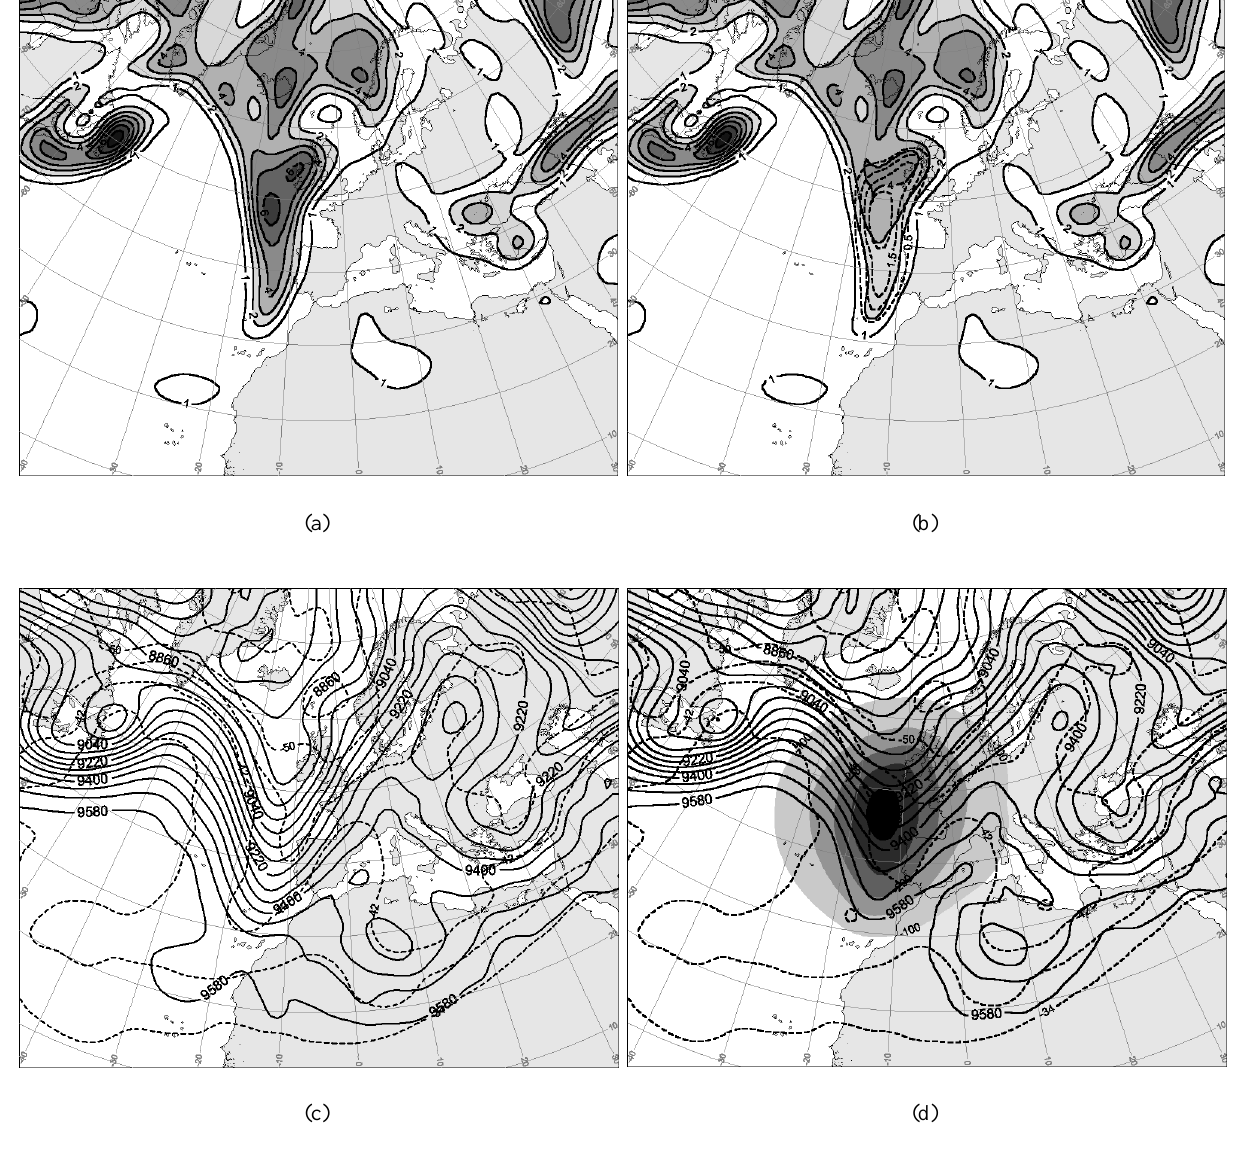
Fig. 15. Upper panels: Potential Vorticity (PVU) at 300hPa on 12:00UTC, 20 October 2000 associated with the initial conditions of (a) control run and (b) weakened trough experiment (see text for details). Dashed line in b) depicts the eliminated PV anomaly at 300hPa. Lower panels: Geopotential height (gpm, solid line) and temperature ( ◦ C, dashed line) at 300hPa on 12:00UTC, 20 October 2000 for (c) control run and (d) the weakened trough experiment. Shading in d) depicts the areas with difference of geopotential height between the control run and weakened experiment greater than 100gpm (contour interval is 50gpm). All panels show the fields on domain